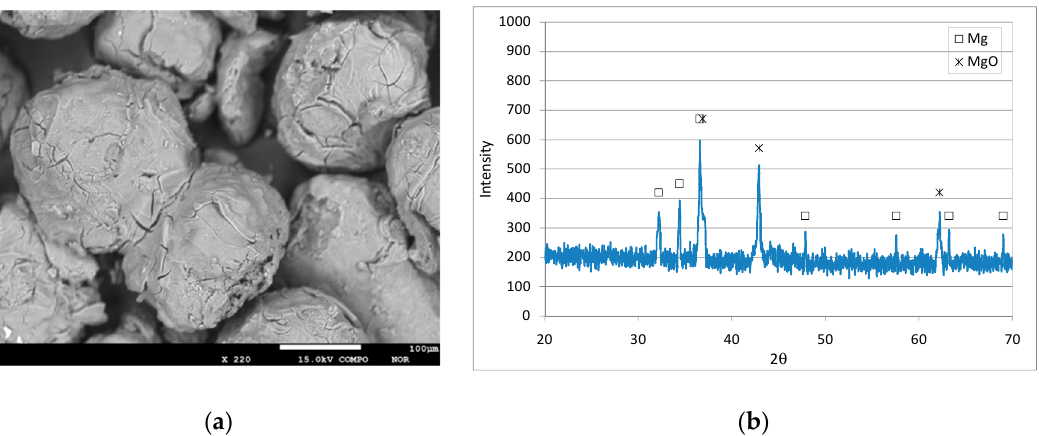
Figure 7. SEM image ( a ) and XRD diffractogram ( b ) of Mg 0 particles after the treatment of the solution with initial N-NO 3 − = 20 mg/L at pH 5.